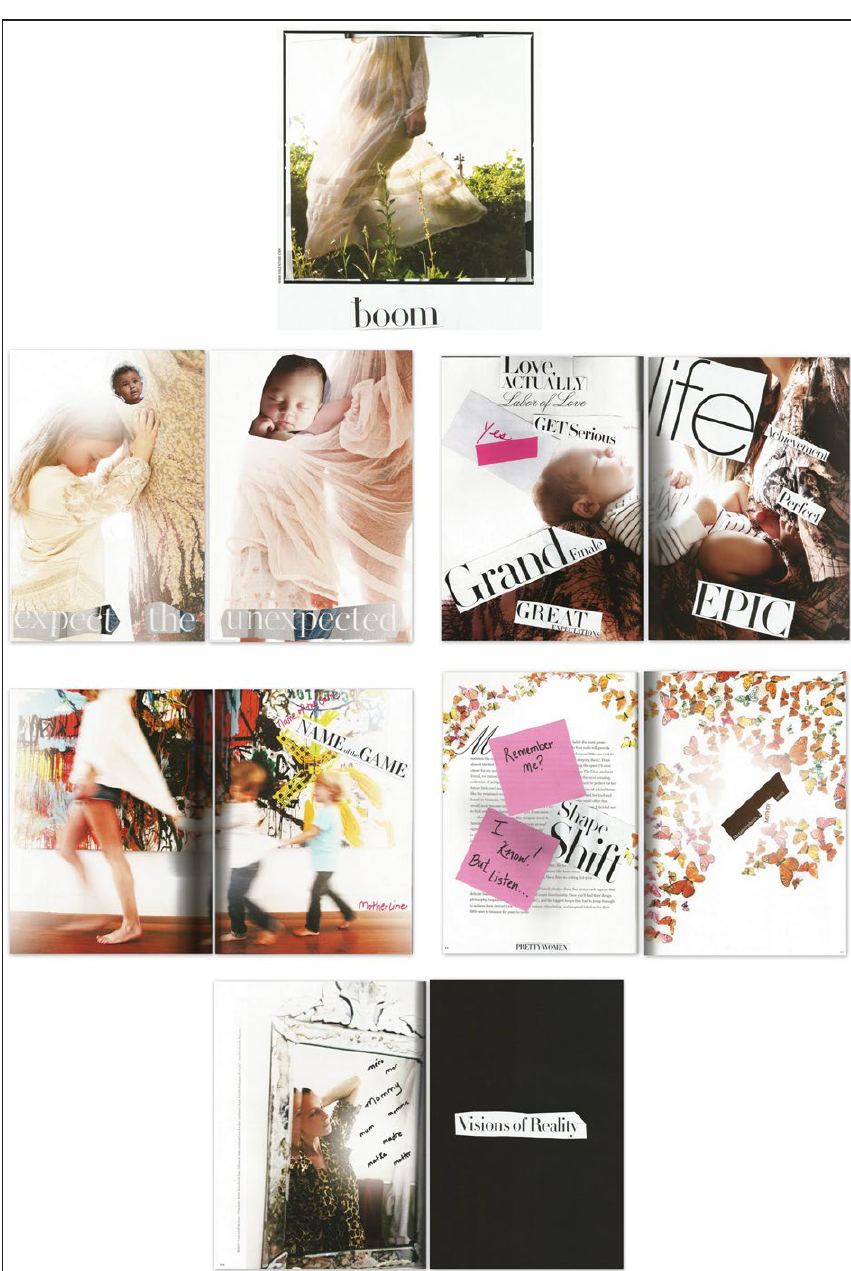
Figure 2: Altered book 2: